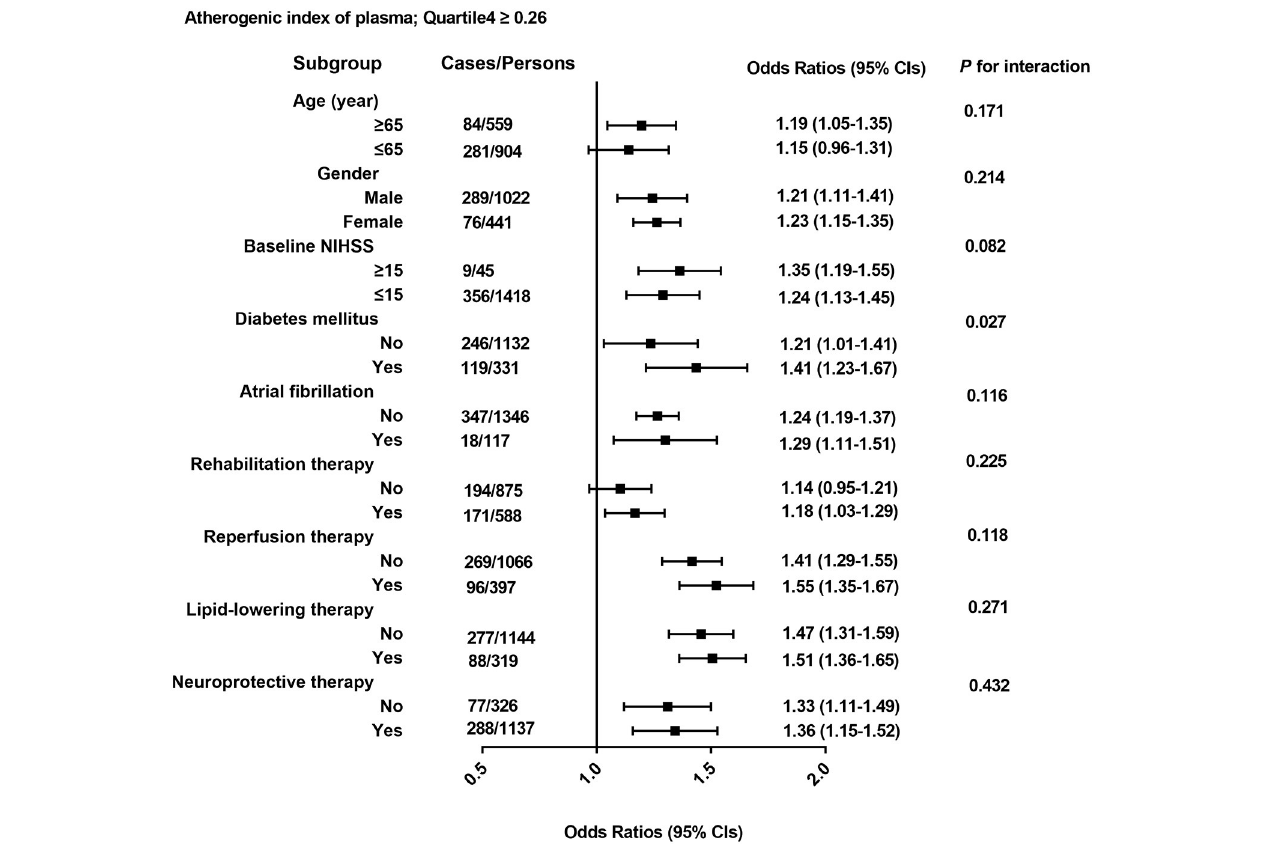
FIGURE 3 | All odds ratios were calculated with AIP. Quartile < -0.10 as the reference groups, with models adjusted for age, gender, and baseline NIHSS; history of lipid-lowering therapy; reperfusion therapy; history of atrial fibrillation; and history of diabetes mellitus, glucose, TC, and LDL-C. Each group adjusted for the other covariates except